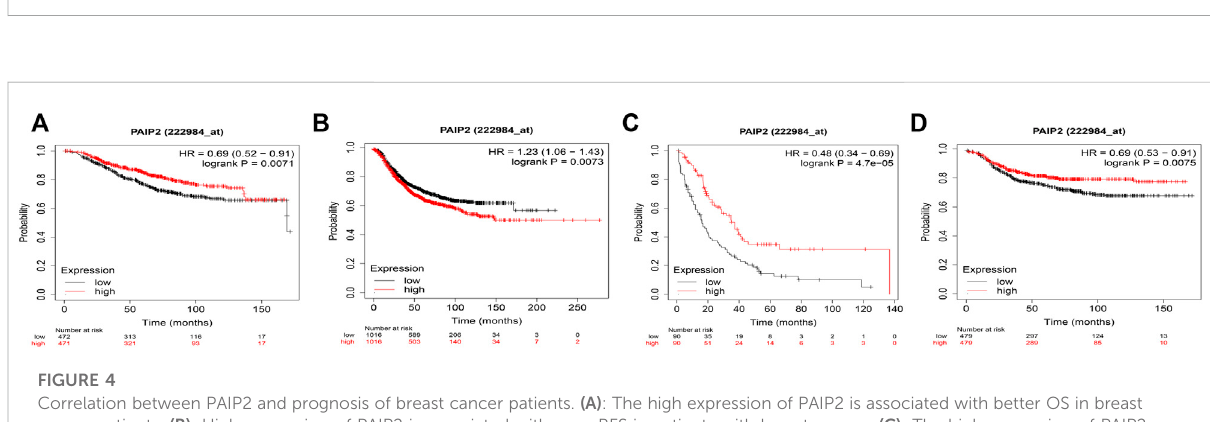
TCIA database showed that PAIP2 low expression group had higher IPS than PAIP2 high expression group, and had better response to immune checkpoint inhibitors (Figures 7C – F).